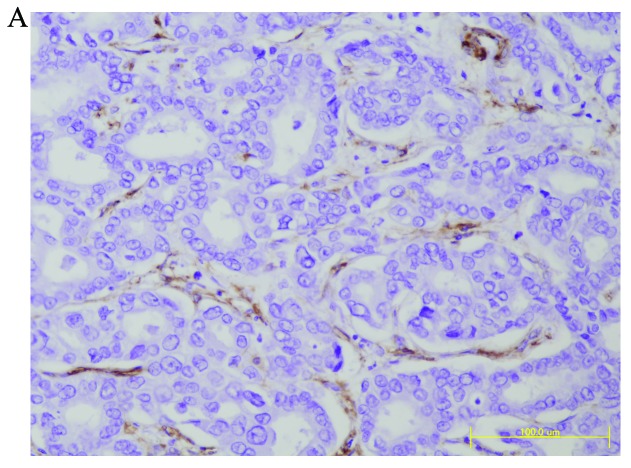
Representative immunohistochemical staining for α-smooth muscle actin (α-SMA) in hepatocellular carcinoma (HCC) tissue sections of living donor liver transplantation (LDLT) patients. (A) α-SMA positivity in cancer-associated fibroblasts (CAFs) of HCC is low grade (<1.0%). (B) α-SMA positivity in CAF of HCC is middle grade (<10%). (C) α-SMA positivity in CAF of HCC is high grade (≥10%).